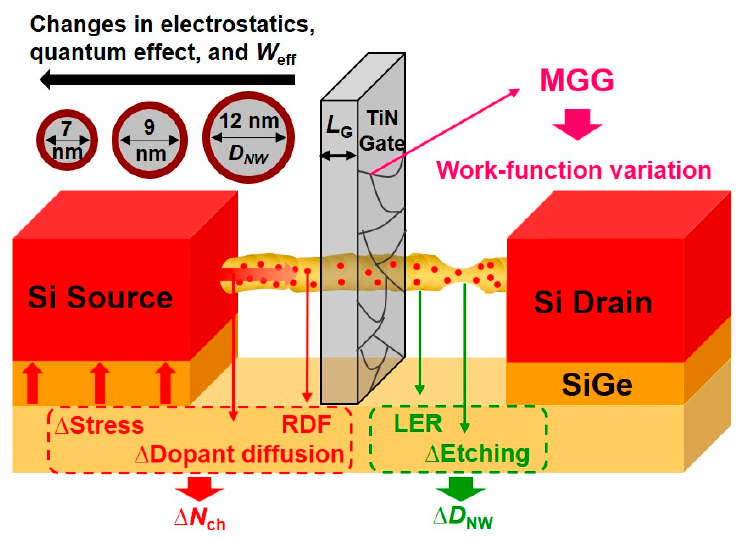
Figure 1. Schematic of the silicon nanowire field-effect transistor (SNWFET) and possible V th variation sources.